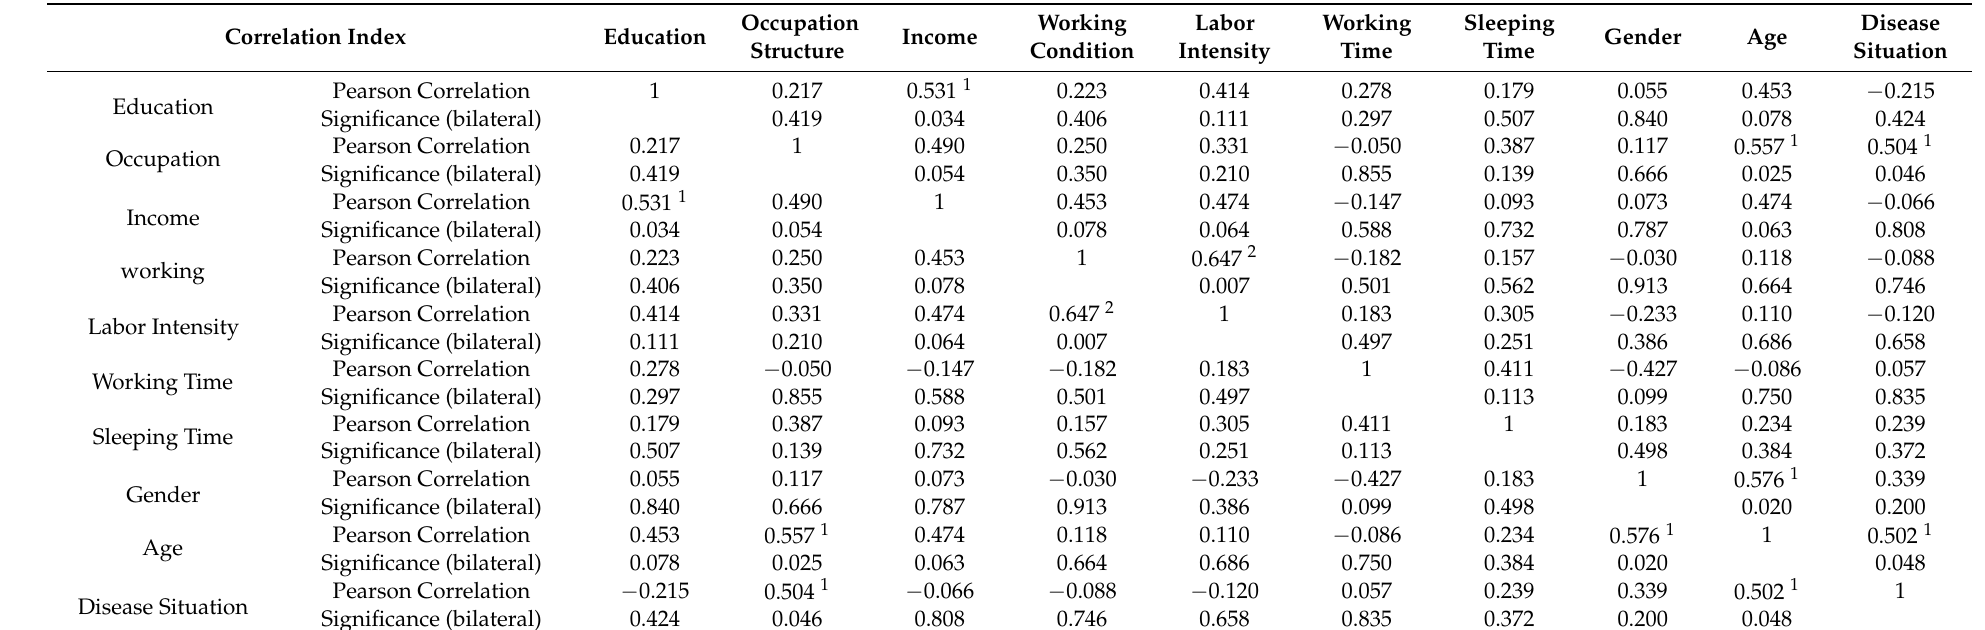
Table 5. Relevance analysis of